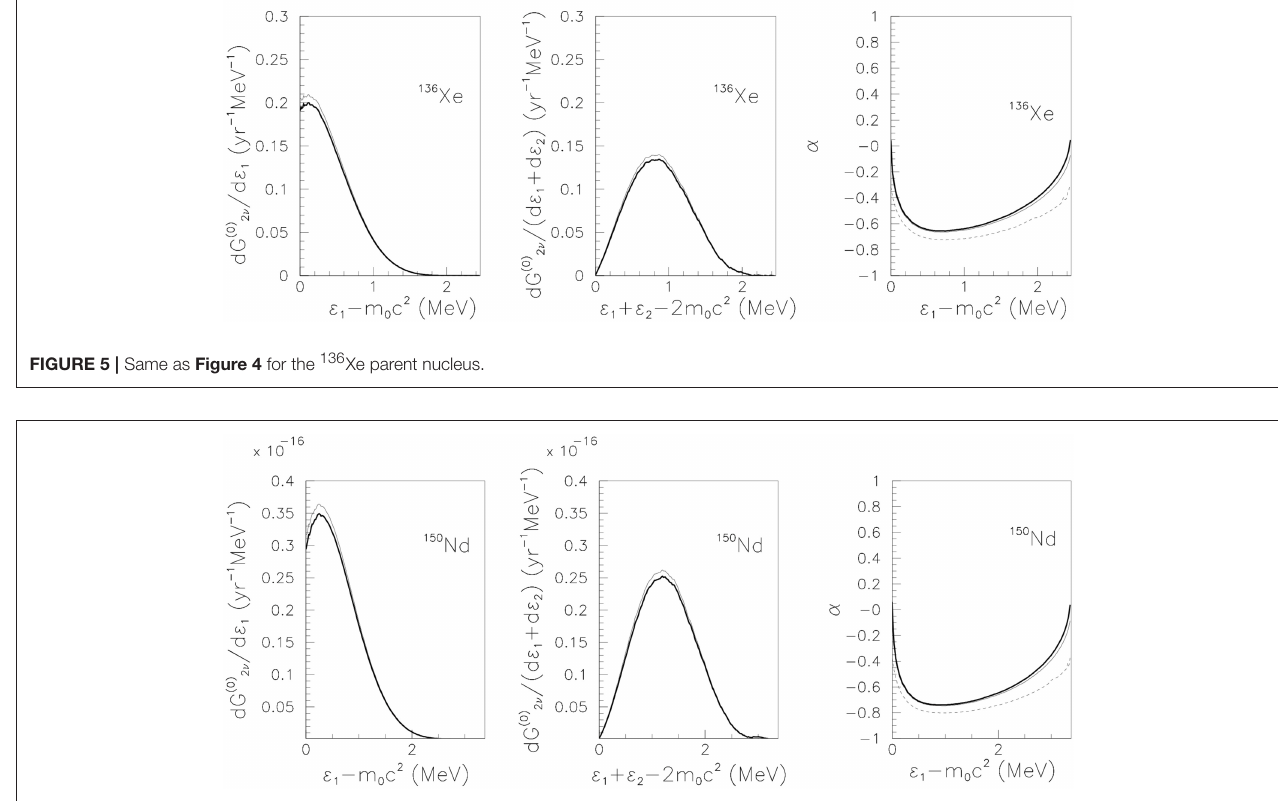
FIGURE 6 | Same as Figure 4 for the 150 Nd parent